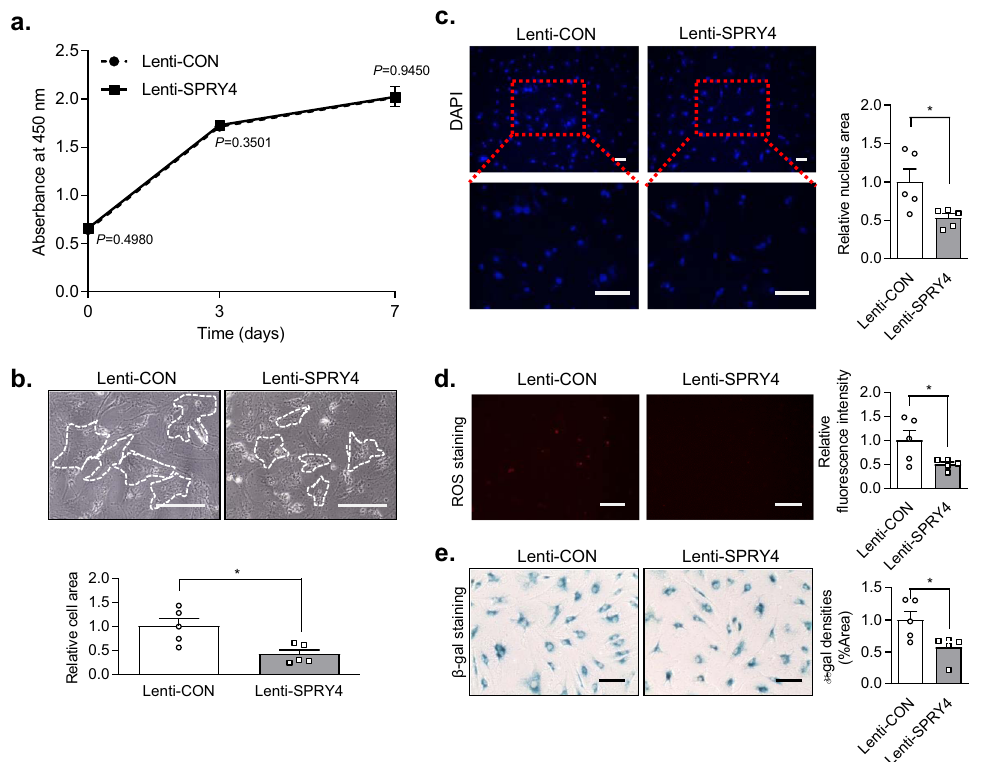
Fig. 4 Effect of SPRY4 overexpression on hypertrophy in DCs. a CCK-8 cell proliferation assay for the control lentivirus (Lenti-CON)-treated and SPRY4 lentivirus (Lenti- SPRY4 )-treated DCs by time ( n = 3, unpaired t -test with Welch ’ s correction). b Microscopic images of Lenti-CON- treated and lenti- SPRY4 -treated DCs ( n = 5, unpaired t -test with Welch ’ s correction) Scale bars, 200 μ m. The data represent the mean ± SEM ( c ) DAPI staining of Lenti-CON-treated and Lenti- SPRY4 -treated DCs ( n = 5, unpaired t -test with Welch ’ s correction) Scale bars, 100 μ m. d ROS staining of Lenti-CON-treated and Lenti- SPRY4 -treated DCs ( n = 5, unpaired t -test) Scale bar, 200 μ m. e β -gal staining of Lenti-CON-treated and Lenti- SPRY4 -treated DCs ( n = 5, Mann Whitney test) Scale bar, 200 μ m. All data represent the mean ± SEM. Abbreviations: CCK-8, cell counting kit-8; DAPI, 4 ′ ,6-diamidino-2-phenylindole; ROS, reactive oxygen species; β -gal, β